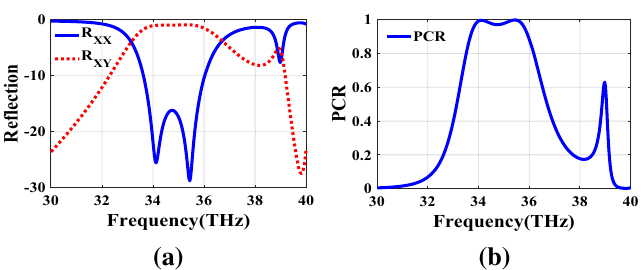
Figure 3. ( a ) Reflection coefficients of co and cross polarized reflected waves for the first structure, ( b ) PCR of the first structure.